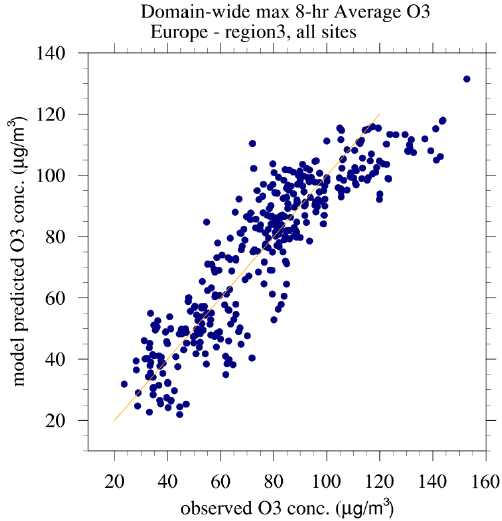
Figure 14. Scatter plot of maximum 8h running average ozone con- centration in central